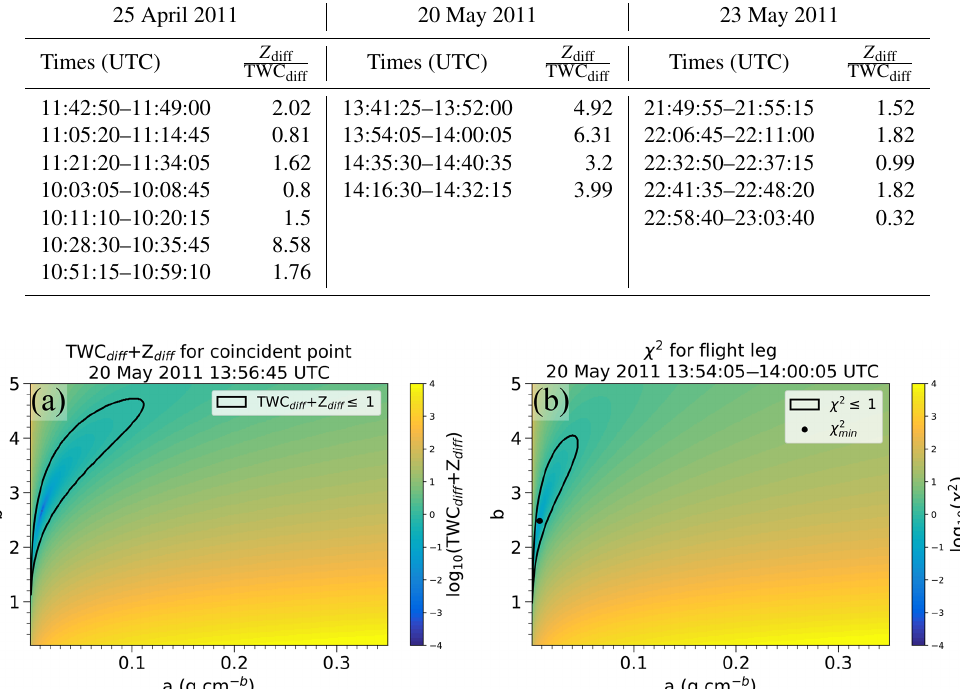
as (cid:49)χ 2 = max (χ 2 ural parameter variability over a flight leg, (cid:49)χ 2